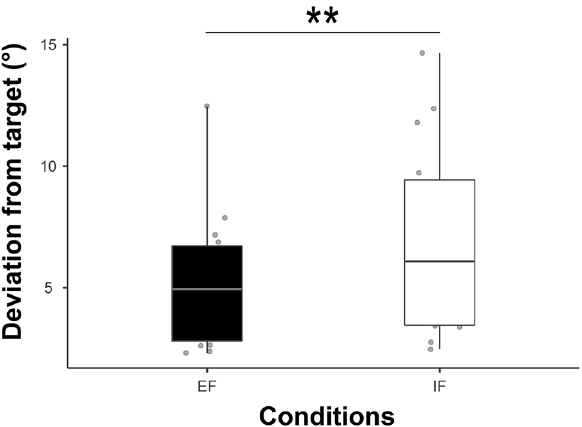
Figure 2. Shown are individual values ( n = 14) and boxplots comparing both attentional foci (EF and IF) of the deviation from the target position of the pedal in degrees (°). Participants could better match the target line by moving the pedal with their foot when adopting and EF contrasted to an IF (around + 24% improvement). Left boxplot (black) represents the external focus of attention condition (EF) and the right one (white) the internal focus of attention condition (IF). ** P ≤